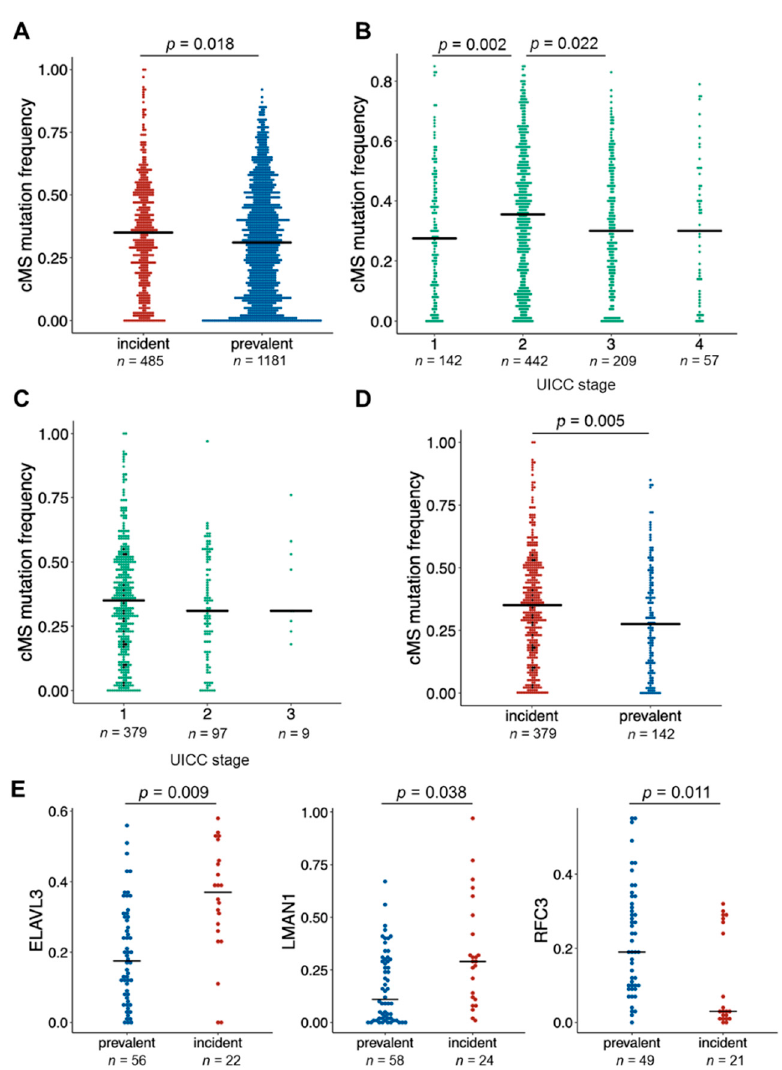
Figure 4. Analysis of coding microsatellite (cMS) mutations in incident and prevalent LS CRC. ( A ) cMS mutation frequency in incident and prevalent LS CRC. ( B ) cMS mutation frequency in prevalent LS CRC by UICC stage. ( C ) cMS mutation frequency in incident LS CRC by UICC stage (stage I group includes data from UICC 0 tumor, see black data points). ( D ) cMS mutation frequency in stage I incident (stage I group includes data from UICC 0 tumor, see black data points) and stage I prevalent LS CRC. ( E ) Individual cMS with significantly differing mutation rates between incident and prevalent cancers. Each dot represents one cMS locus in one tumor, and the n indicates the total number of analyzed cMS loci multiplied by the number of analyzable tumors. p values were calculated using a two ‐ sample Wilcoxon test (Mann–Whitney) and corrected for multiple testing using Benjamini–Hochberg procedure.